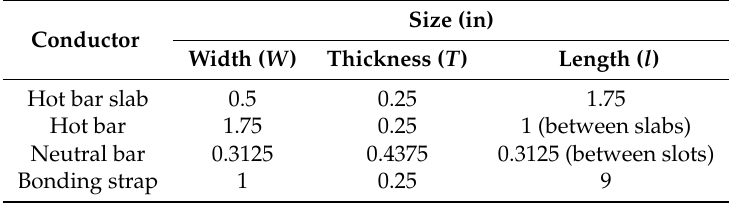
Table 2. Parameters of Rectangular Conductors in the